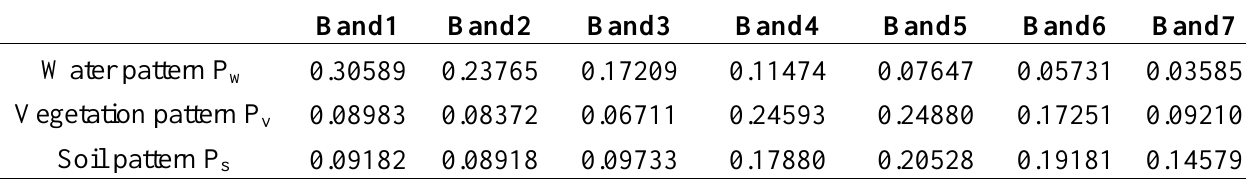
Table 2. Standard spectrum patterns in Shandong